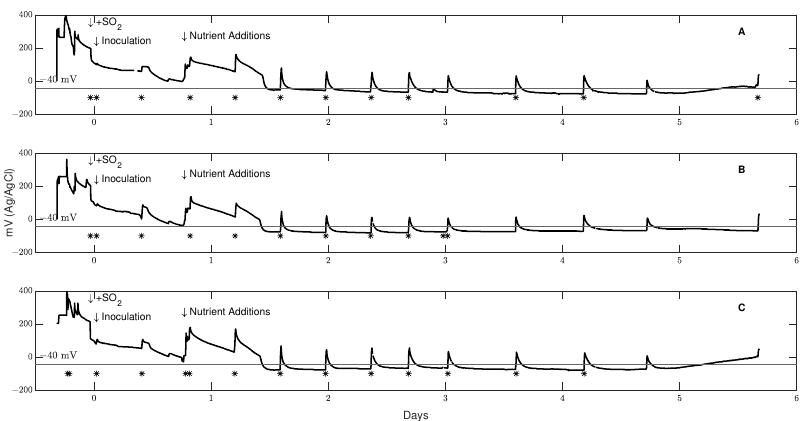
Figure 5. Uncontrolled redox fermentations ( A ) (100 L), ( B ) (100 L) and ( C ) (100 L) with pump-over indicated by (*).